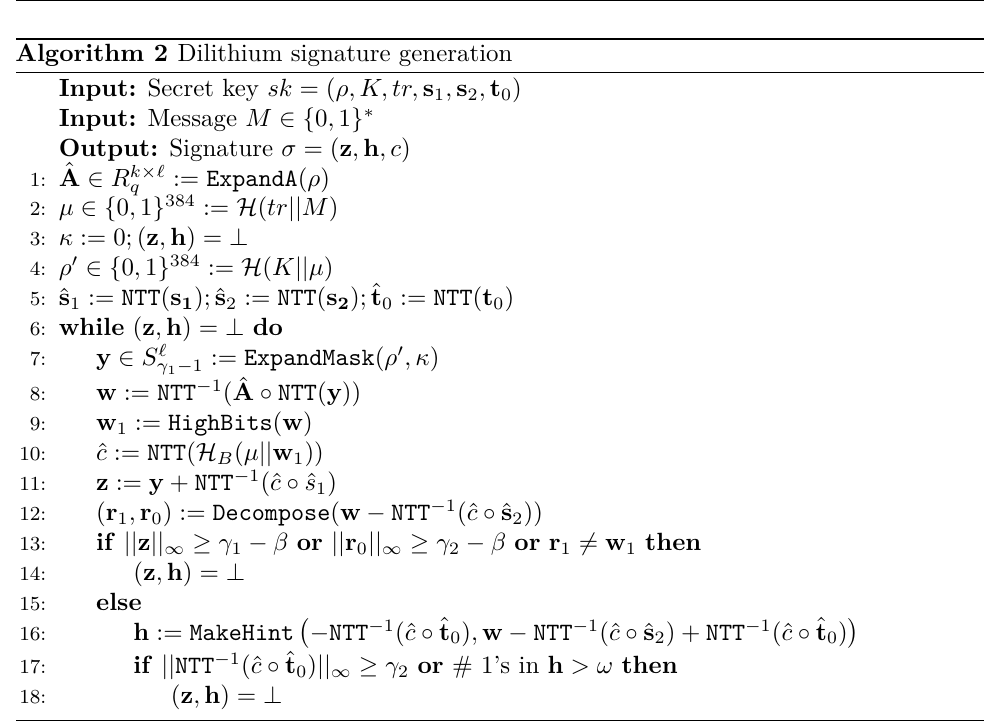
Algorithm 2 Dilithium signature